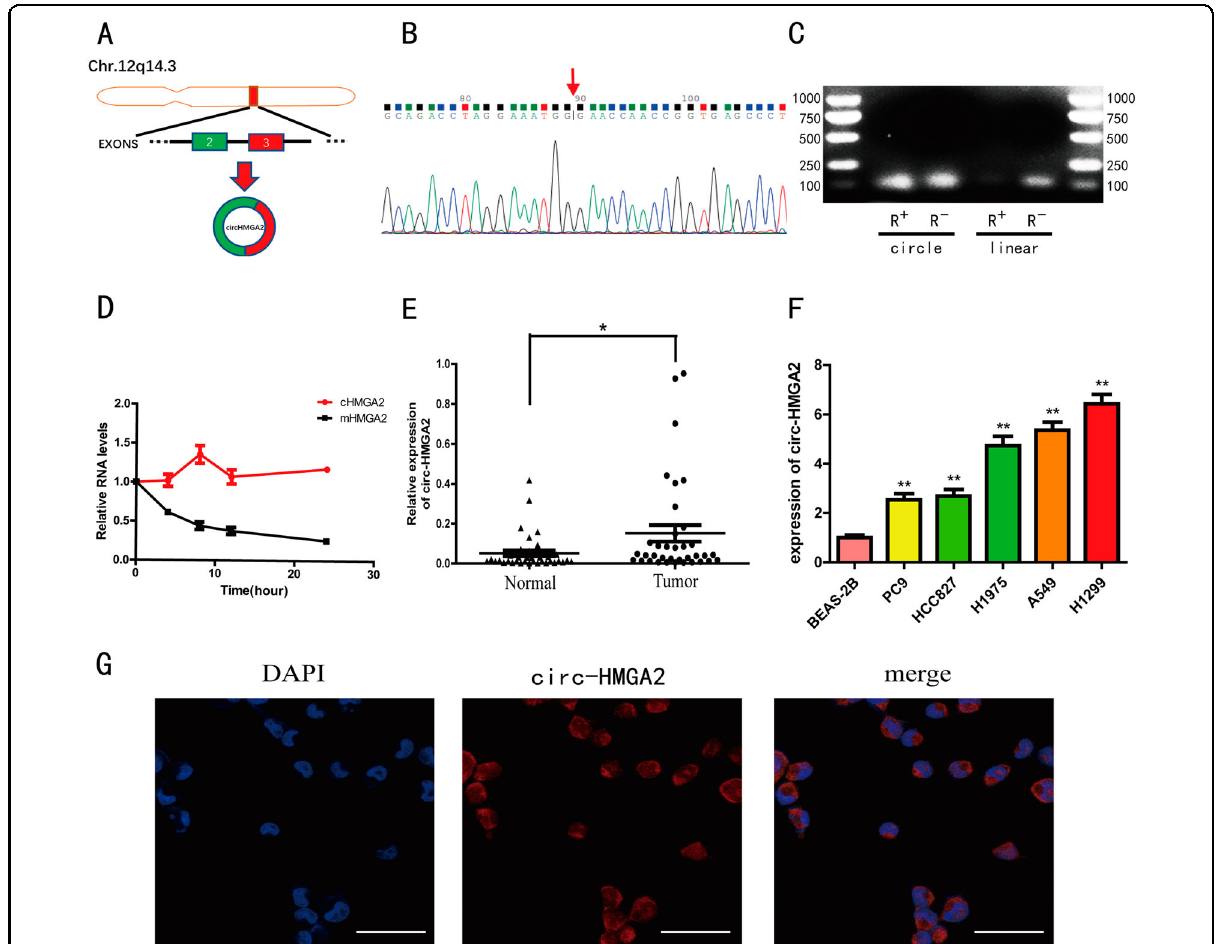
Fig. 2 Characteristics of circ ‐ HMGA2 in LUAD cells. A The schematic illustration showing that circ-HMGA2 is cyclized from exons 2-3 of HMGA2. B Sanger sequencing showed the back-splice junction sites in circ-HMGA2. C Gel electrophoresis was performed to analyze RNase R digestion. Circ ‐ HMGA2 was resistant to RNase R digestion. D Upon exposure to actinomycin D, circ-HMGA2 was more stable than its linear form. E The relative expression levels of circ-HMGA2 in LUAD tissues and adjacent normal tissues were determined by qRT-PCR. F Circ-HMGA2 was signi fi cantly highly expressed in LUAD cells. G Circ-HMGA2 was localized mainly in the cytoplasm of H1299 cells, as veri fi ed by FISH. Scale bar: 25 μ m. * P <